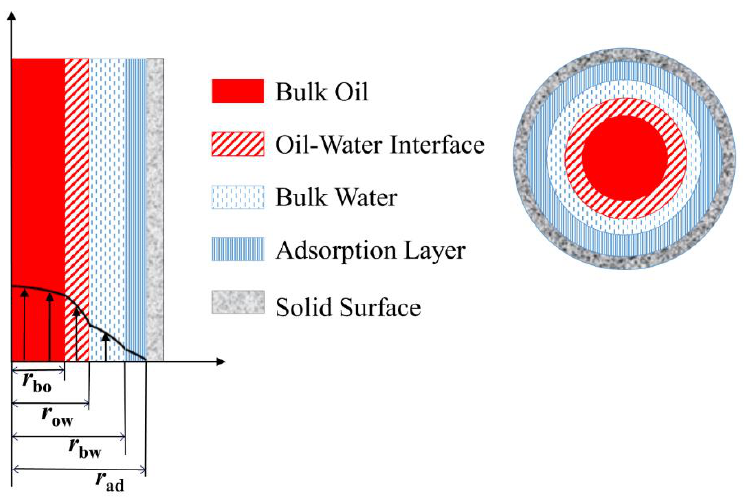
Figure 9. The schematic diagram of the four flow regions of the “apparent viscosity” model.